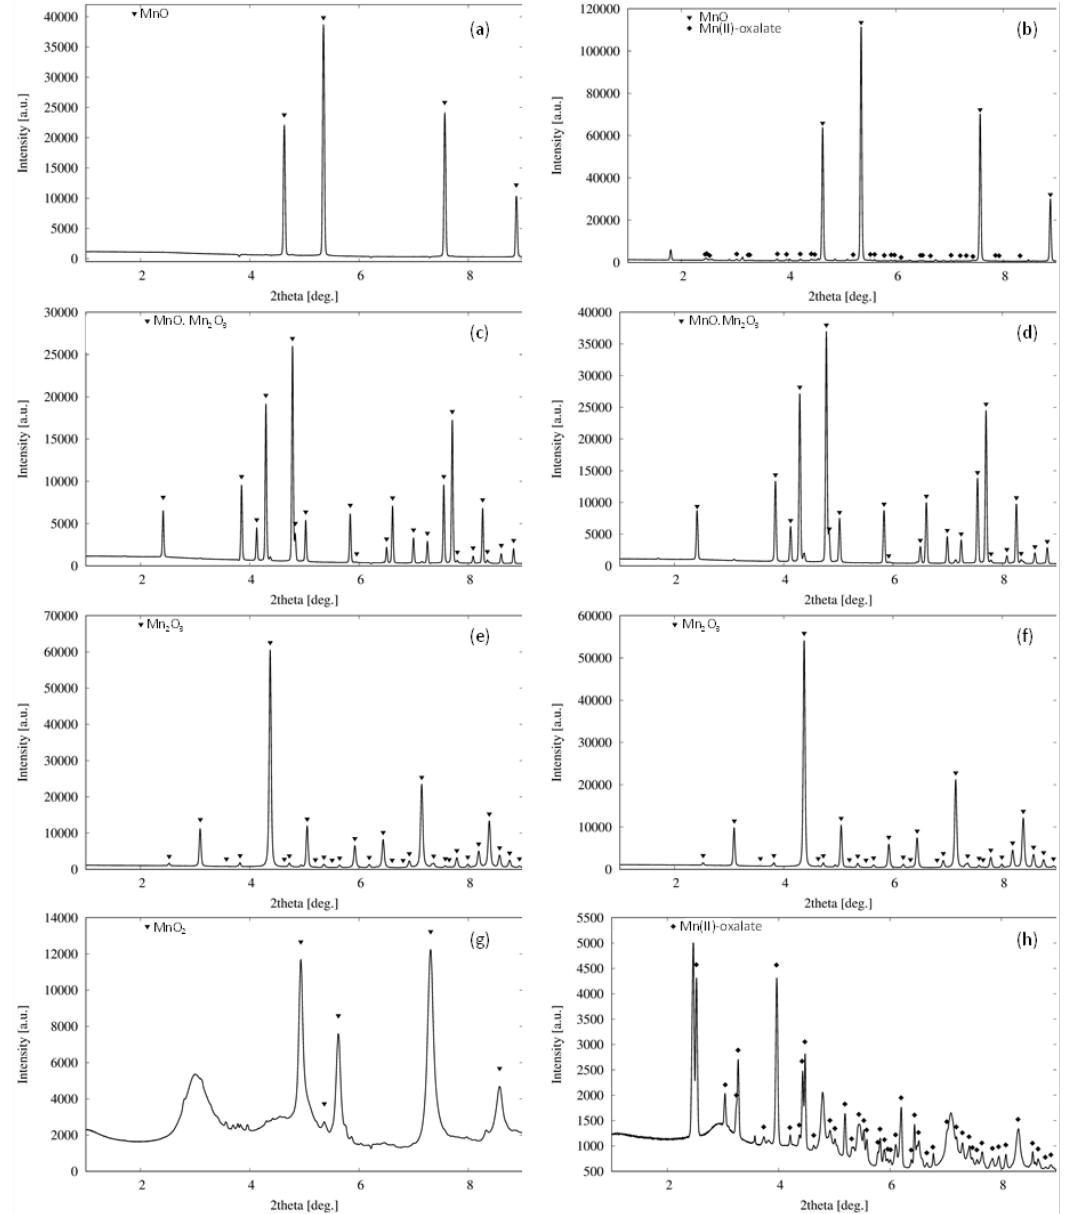
Figure 10. High energy (synchrotron) X-ray diffraction of Mn(II), Mn(II,III), Mn(III) and Mn(IV)-oxides ( a , c , e , g ) at the initiation of a 31-day incubation in the presence of filamentous fungus Aspergillus niger , and ( b , d , f , h ) at the end of cultivation in respective order.